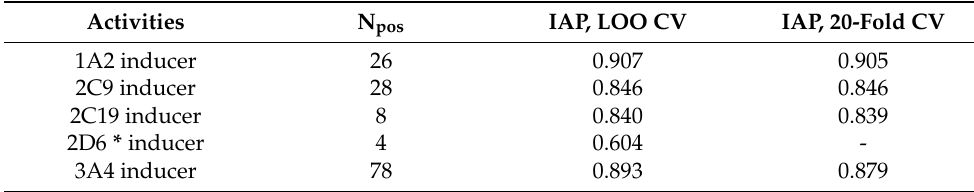
Figure 1. Prediction results for Rifampicin with the created web application. Table 3. Characteristics of selected activities from